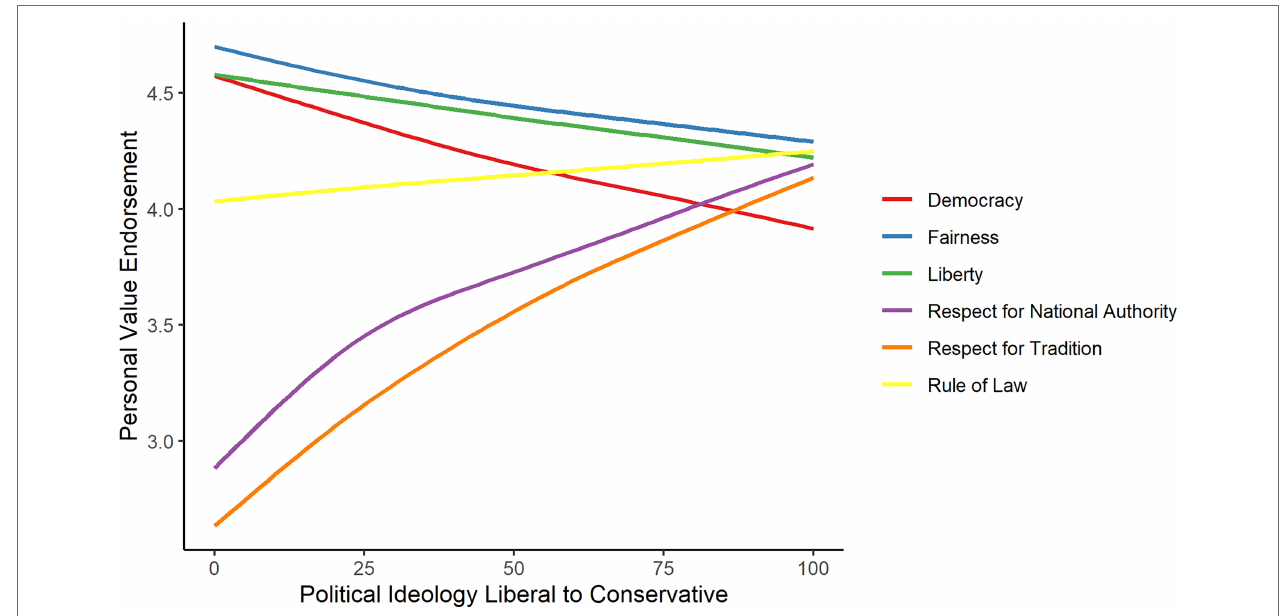
FIGURE 2 | The relation between personal values and political ideology.